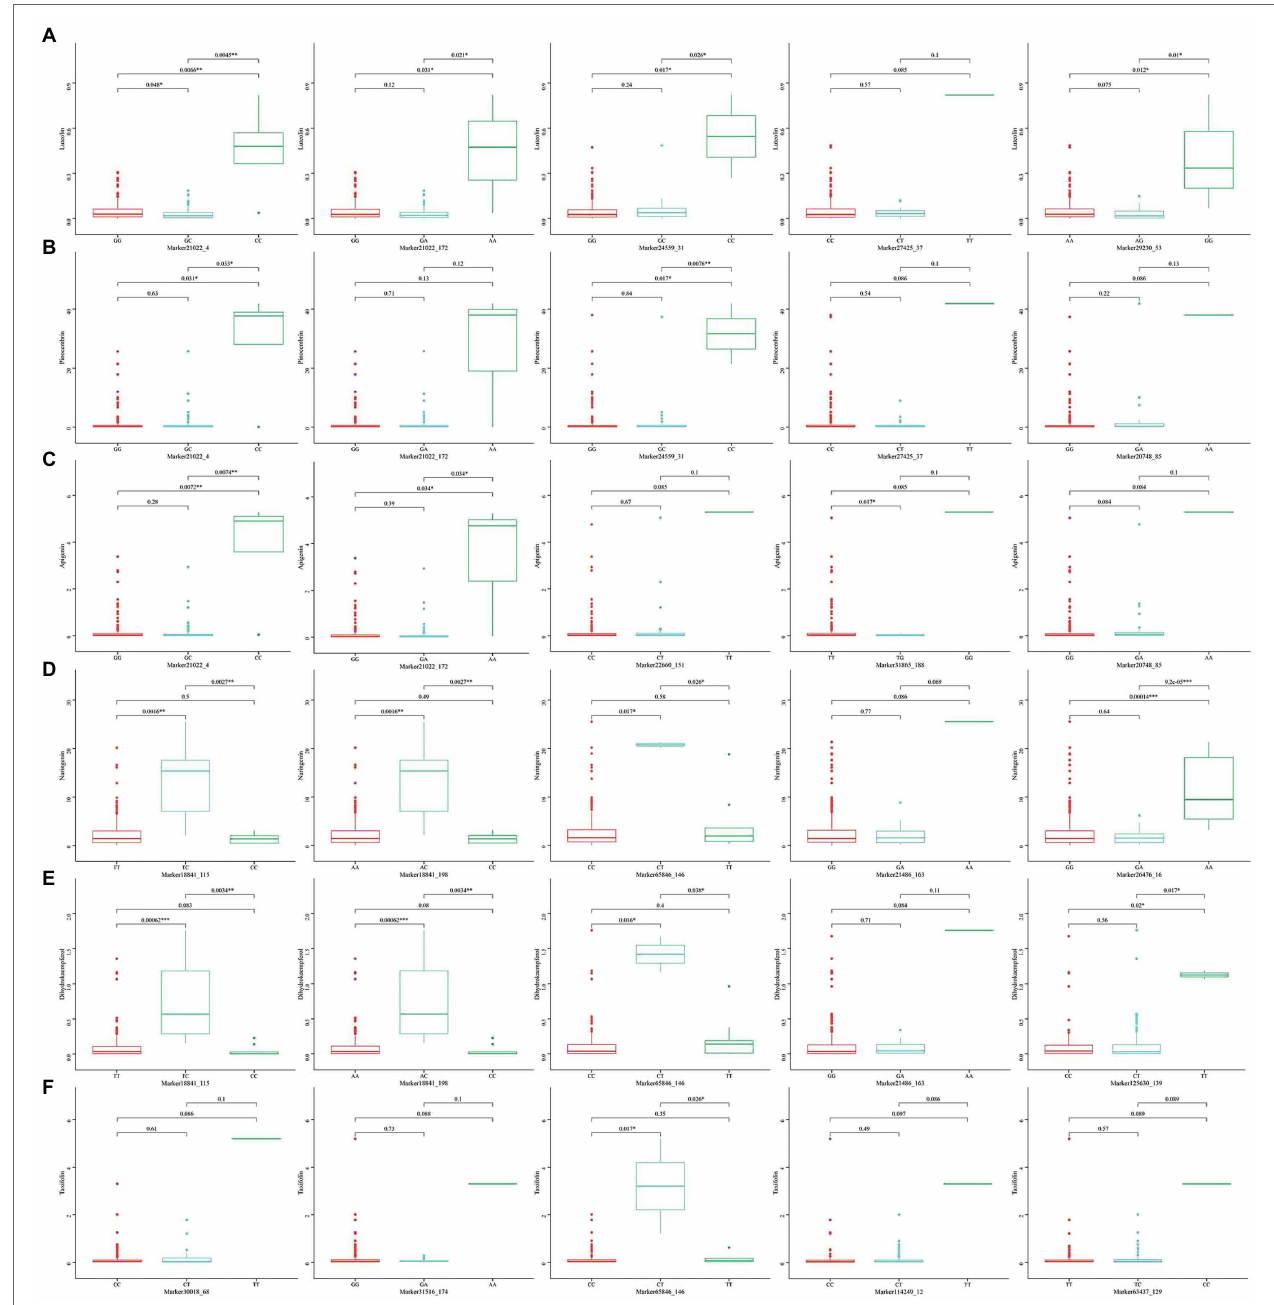
FIGURE 6 | Box plots showing genotype effects of the top five SNPs associated with secondary metabolite contents. (A) Luteolin, (B) pinocembrin, (C) apigenin, (D) naringenin, (E) DK, and (F)